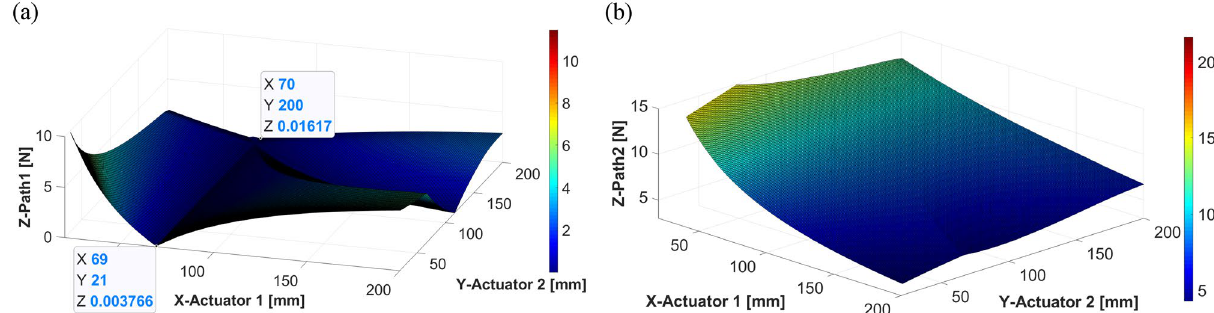
Figure 15. Control force of actuators 1 and 2 when the shaker is placed at 70 mm: ( a ) actuator 1; ( b ) actuator 2 ( generated with MATLAB R2018b, https:// mathw orks. com).